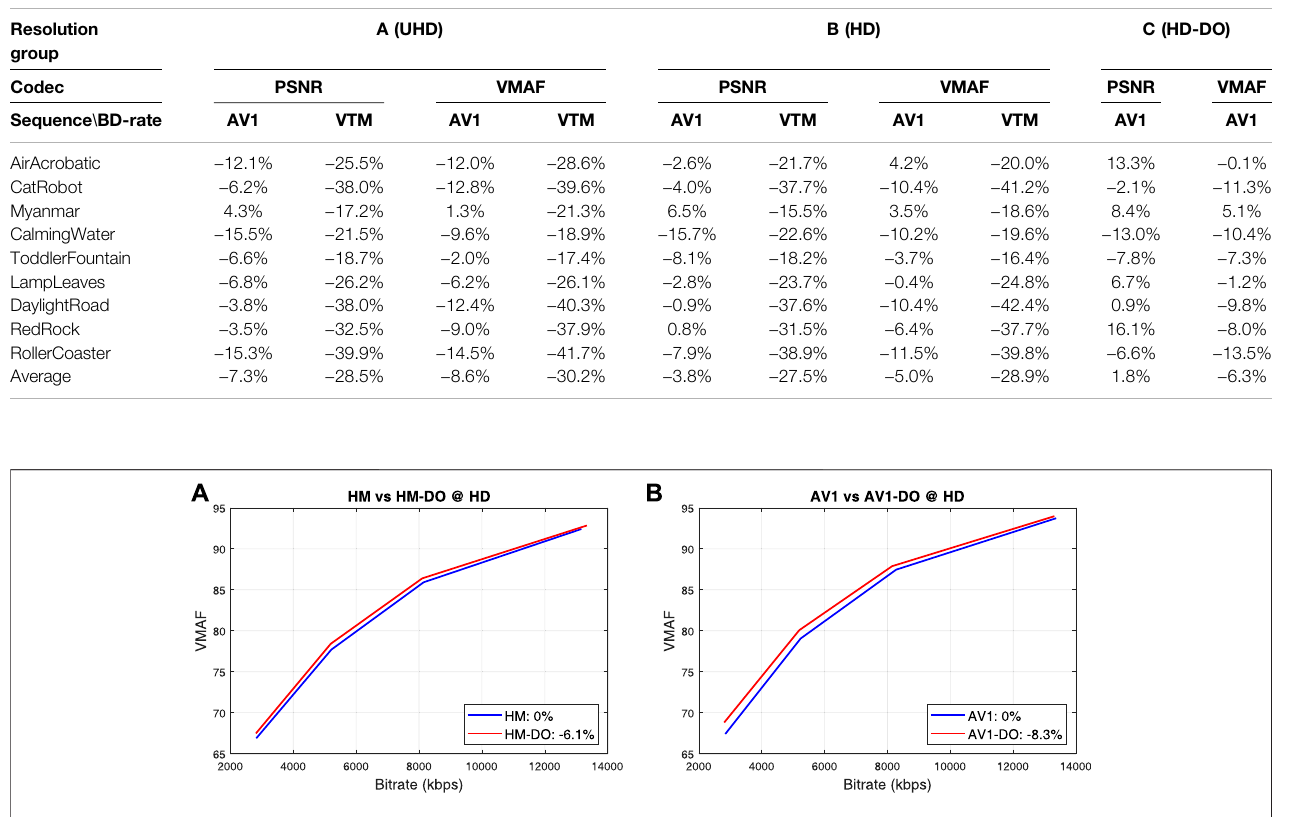
FIGURE 3 | The average rate-VMAF curves of the nine test sequences for (A) HM and (B) AV1 with and without applying